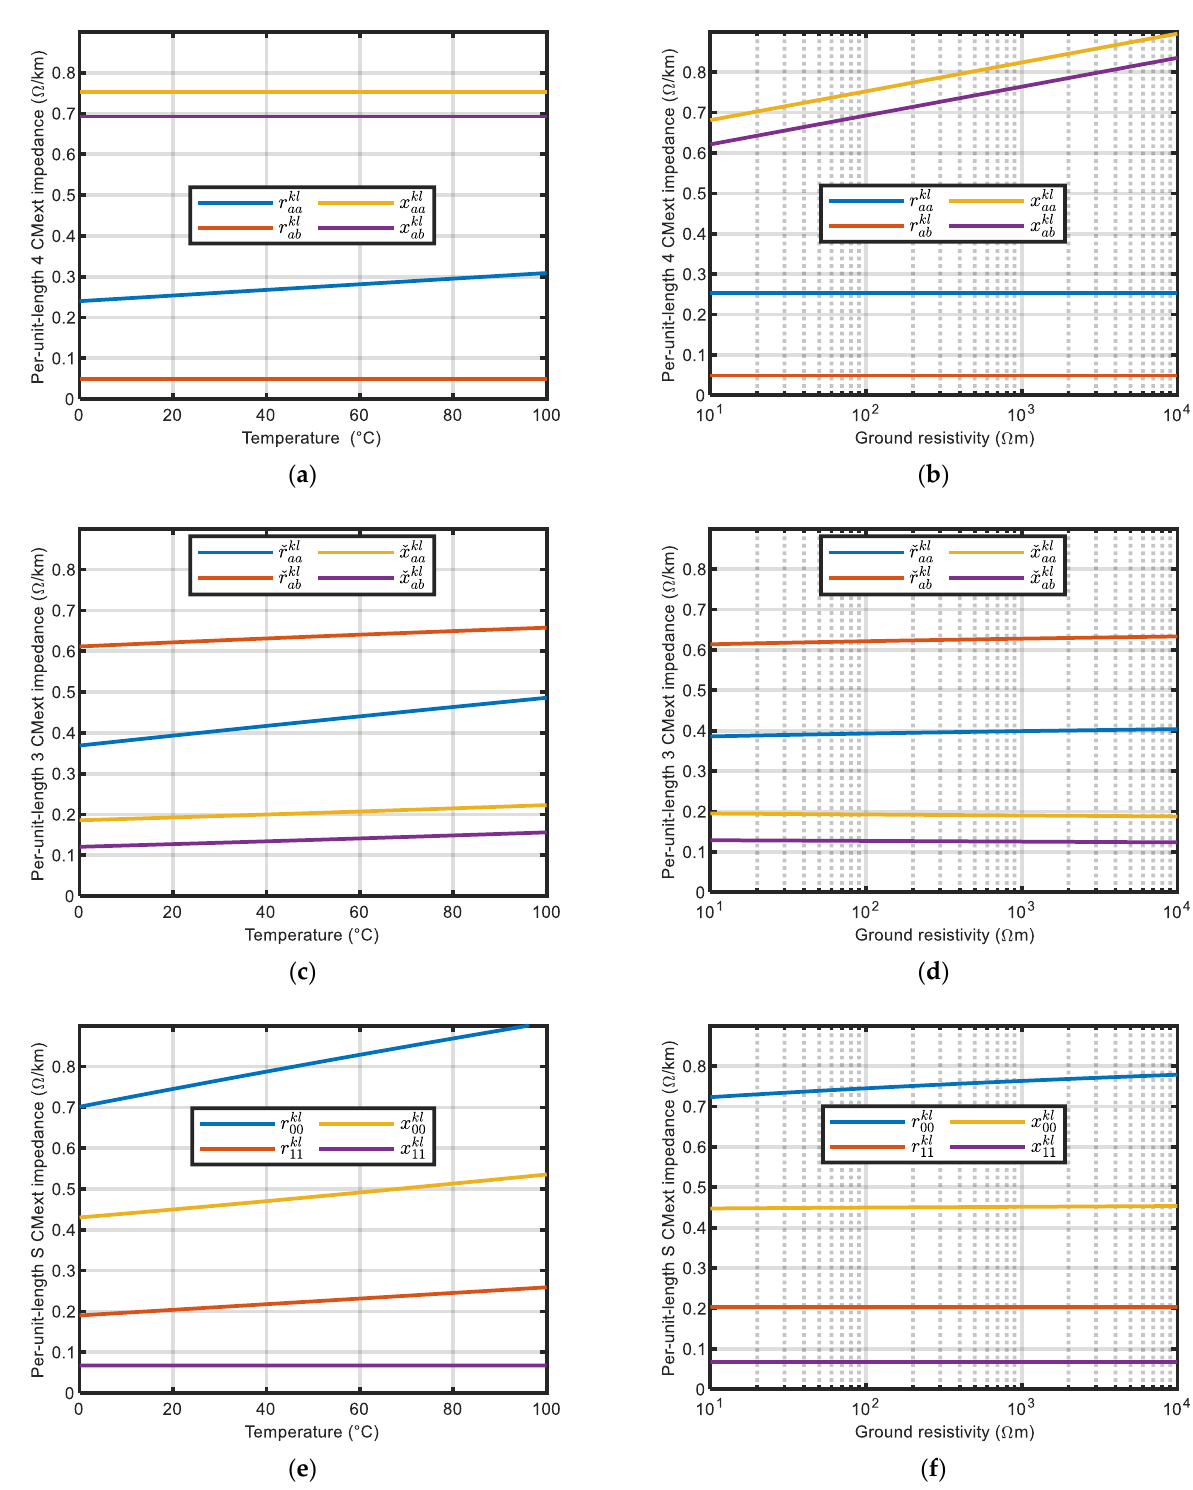
Figure 12. Per-unit-length resistance and reactance of 4 CMext ( a , b ), 3 CMext ( c , d ), and S CMext ( e , f ) with respect to temperature ( a , c , e ) and ground resistivity ( b , d , f ).